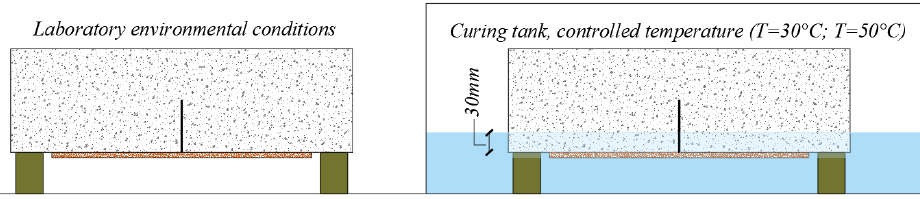
Figure 7. Curing conditions of the specimens considered in this experimental campaign.